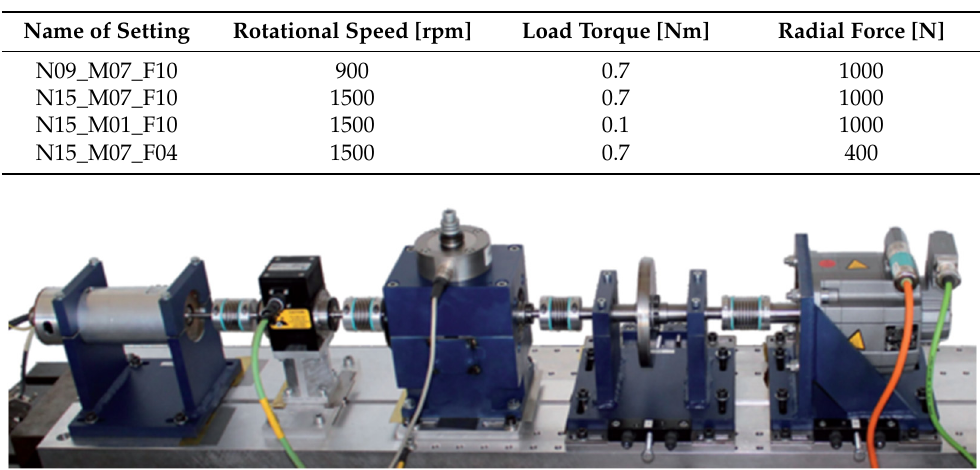
Figure 6. Test rig of Paderborn dataset.